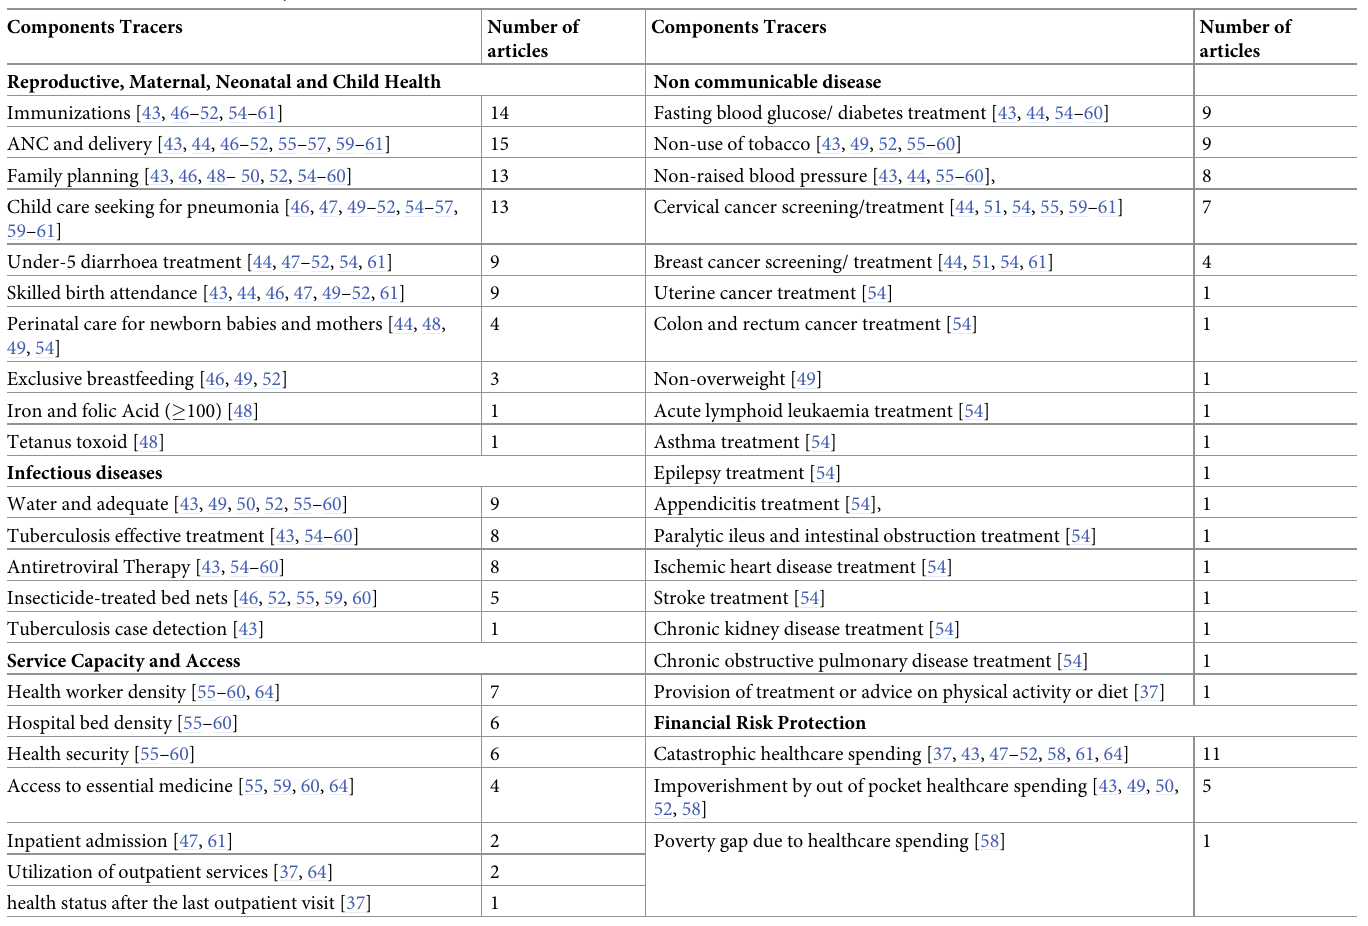
Table 2. Tracer indicators used by studies to estimate